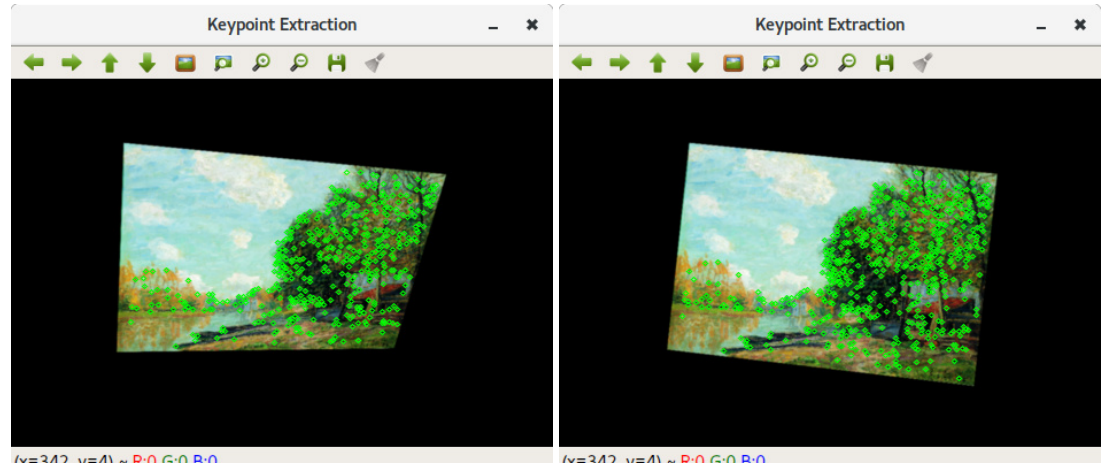
Figure 12. Rendering of a painting in two random perspectives. Detected keypoints are marked with green